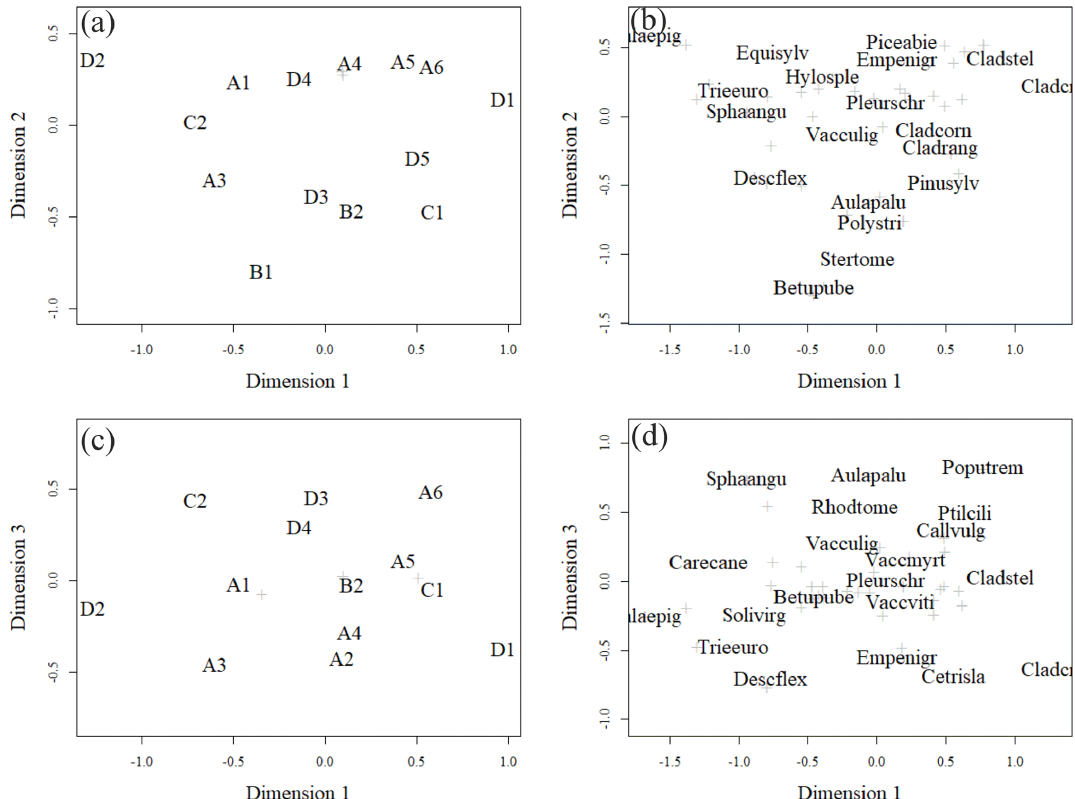
Figure 6. Ordination pattern of the research plots in dimensions 1 and 2 (a, b) and dimensions 1 and 3 (c, d) . Panels (a) and (c) give plot ordinations, and (b) and (d) give weighted averages of the most abundant species (highest cover percentage of the surface). Less abundant species are marked with light-coloured crosses. The names of species are combinations of the first four letters of their genera and species names (e.g. Solivirg stands for Solidago virgaurea ). The tree species mentioned in the figure are at seedling stage. In (a) plots A4, B3, and A2 and in (c) plots A1 and B1, B2 and B3, and A4 and A2 were located on top of each other.